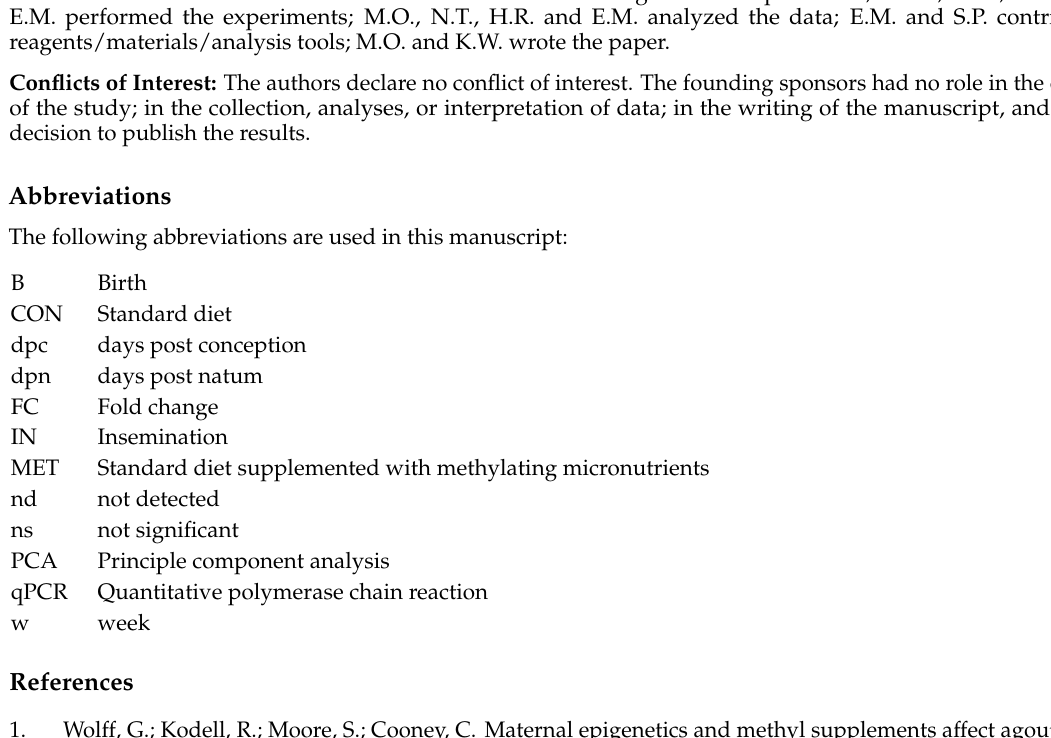
Table S1: Postnatal carcass characteristics related to percent lean mass, back fat, pH, and meat color, Table S2: Gene symbols, accession numbers, primer sequences, and statistics (variance components mediated by diet and diet*sex) of selected genes; see Material and Methods section for details, Table S3: Comparison of Fluidigm and LightCycler 480 results for selected transcripts to verify Fluidigm